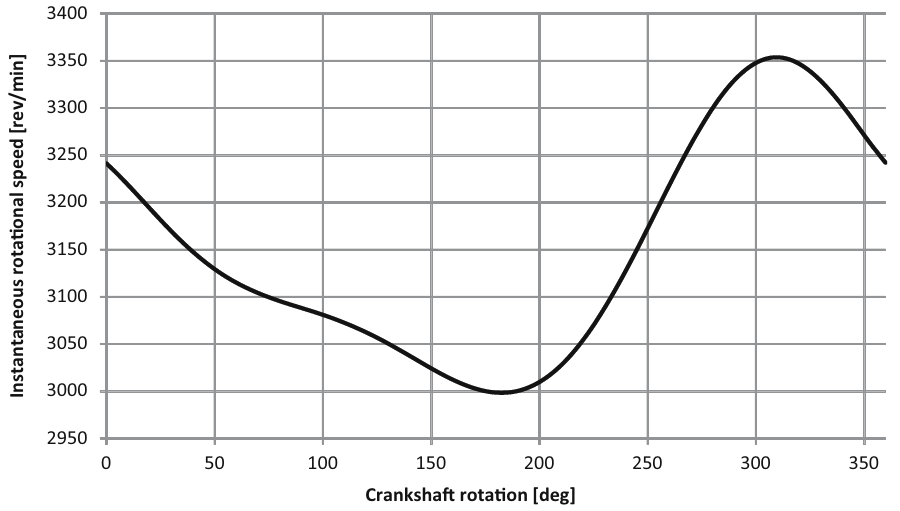
Figure 7: Approximation of crankshaft instantaneous rotational speed during a single revolution for a nominal average rotational speed equal to 3,150 rpm.